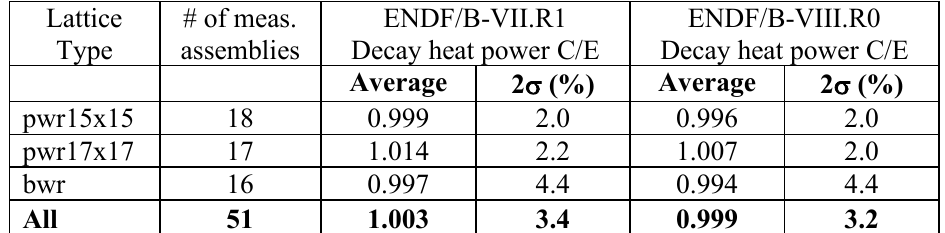
Table II. Comparison summary of C/E between CMS5/SNF and CLAB